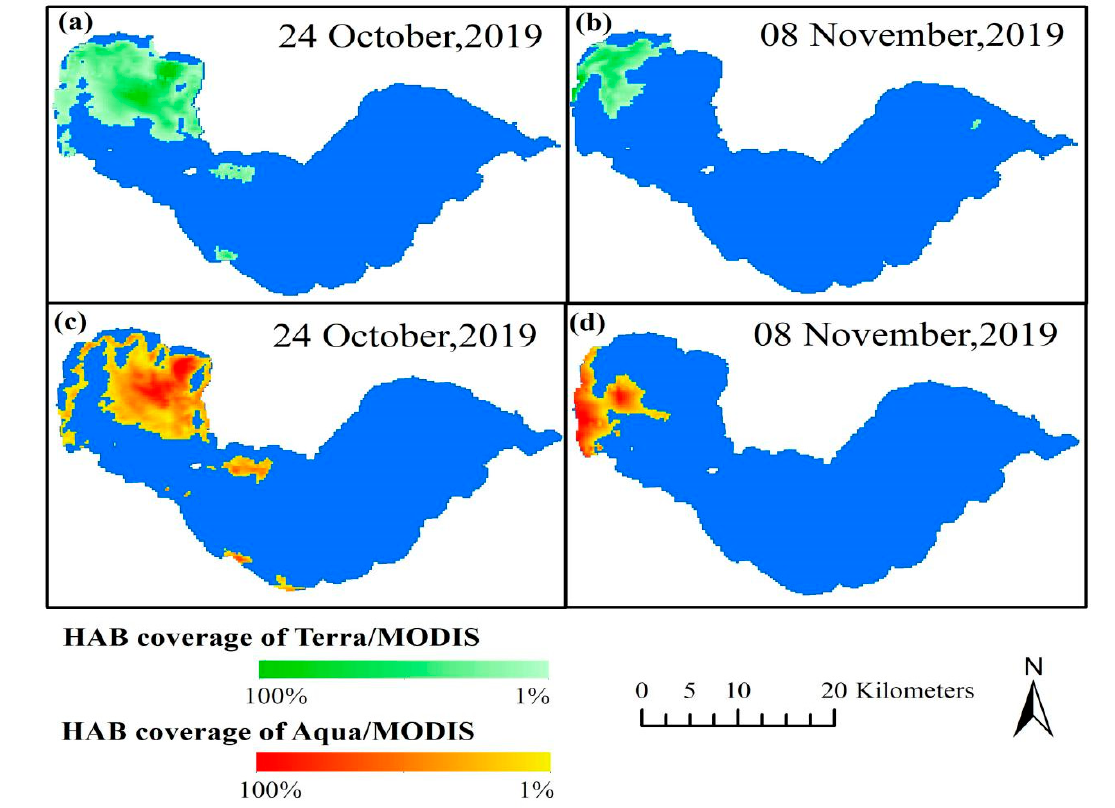
Figure 15. The intraday variations of HAB distribution: ( a ) Terra/MODIS image of the HAB distribution on October 24, ( b ) Terra/MODIS image of the HAB distribution on Novermber 8, ( c ) Aqua/MODIS image of the HAB distribution on October 24, ( d ) Aqua/MODIS image of the HAB distribution on Novermber 8.